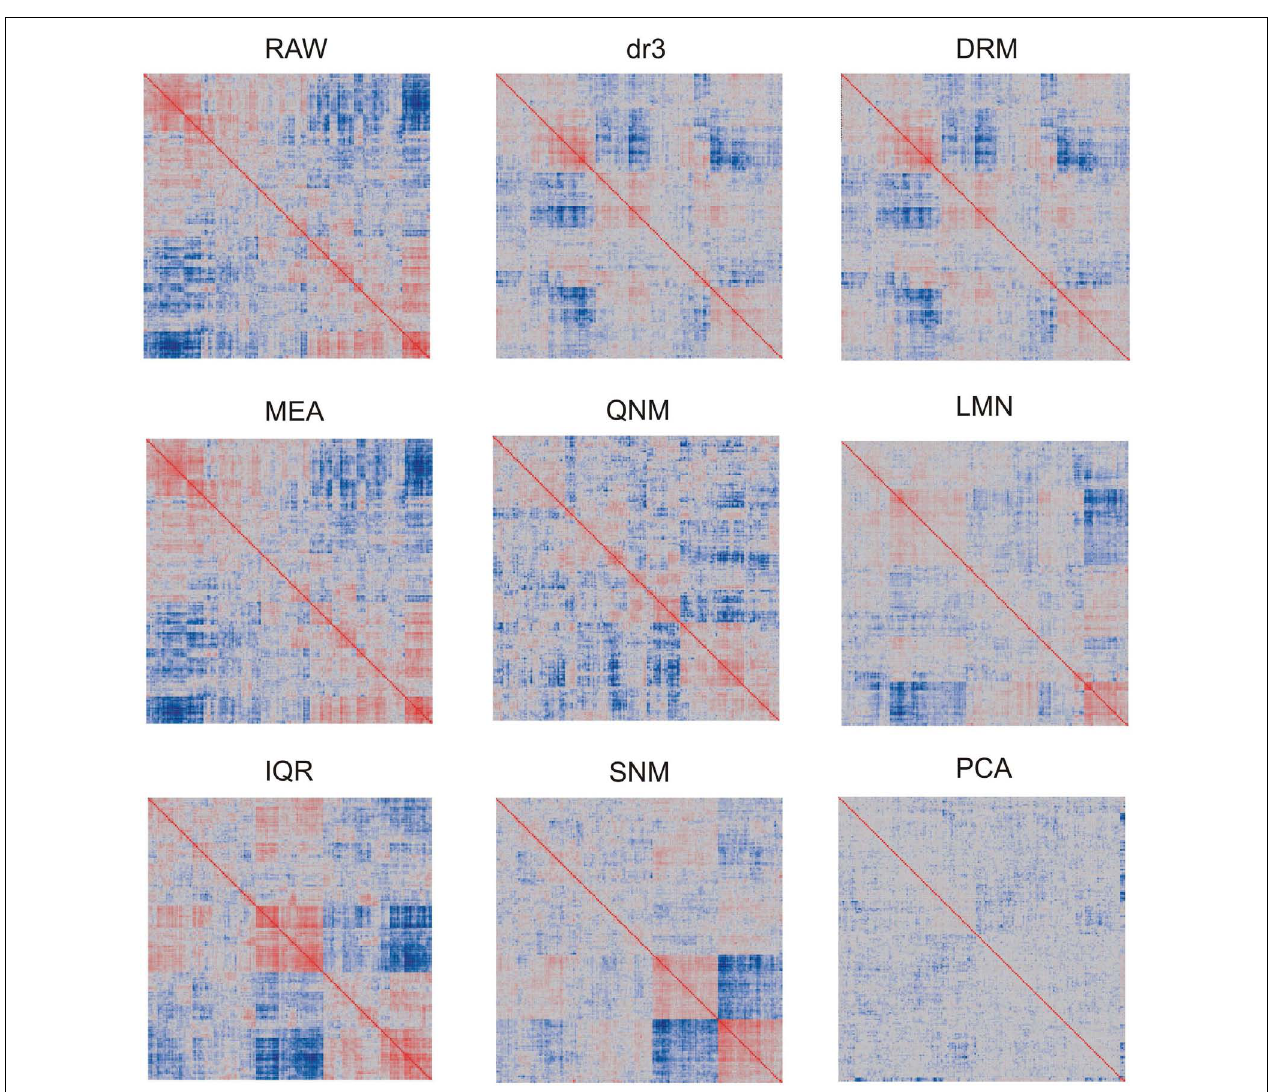
(dark blue) to + 1 (dark red). Blocks of color indicate that arrays in those sectors are less or more similar to one another. Each plot is symmetrical about the